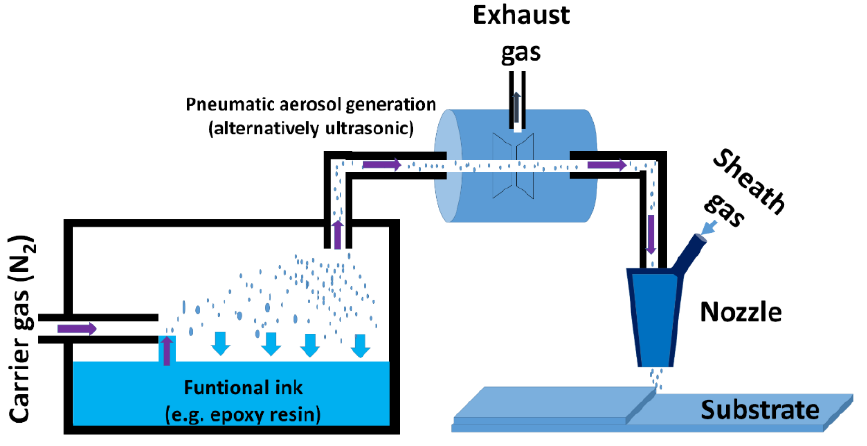
Figure 14. Aerosol jet process [106].